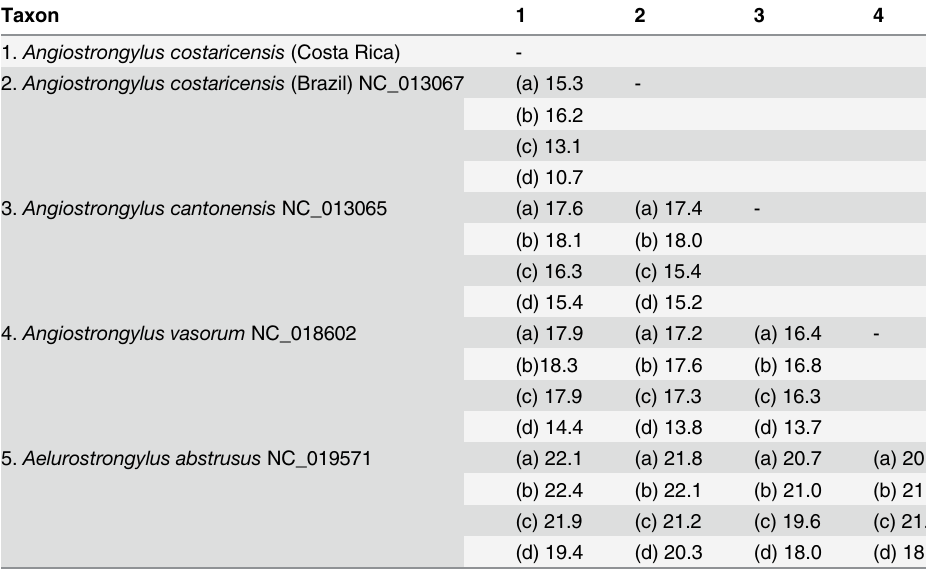
Table 4. Percentage of uncorrected “ p ” distance matrix between Costa Rica and Brazil taxa of Angiostrongylus costaricensis and related taxa based on (a) 36 mt-genes, (b) 12 protein-coding genes, (c) two rRNA genes, and (d) 22 tRNA